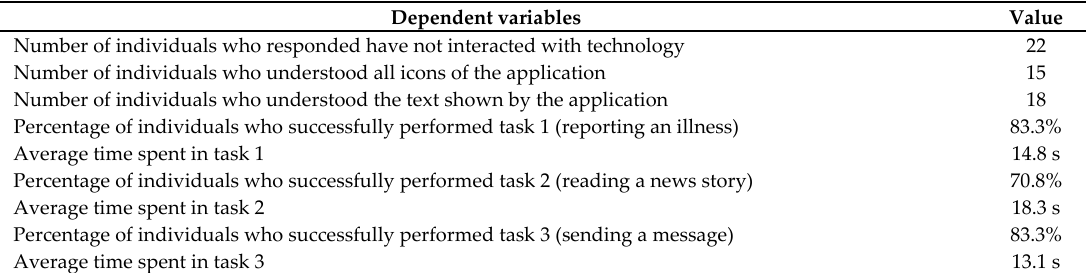
Table 4. Values of the dependent